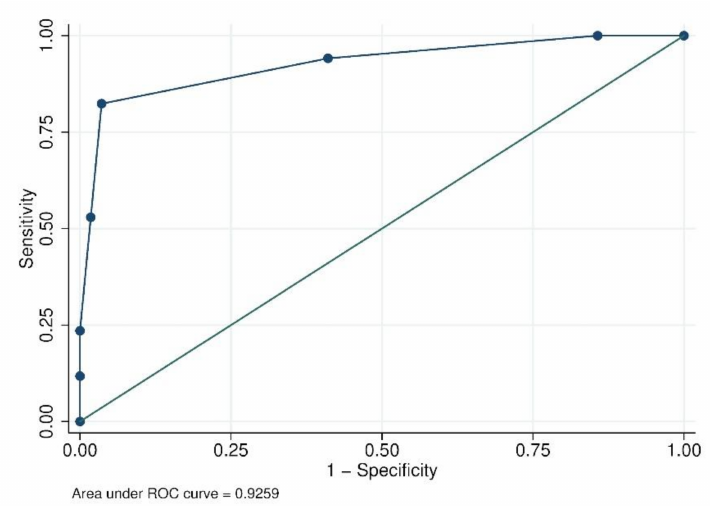
Figure 1. Receiver operating characteristics (ROC) curve for the score model with leukopenia, hypertransaminasemia, myalgia, rash, respiratory symptoms ( b / w ).